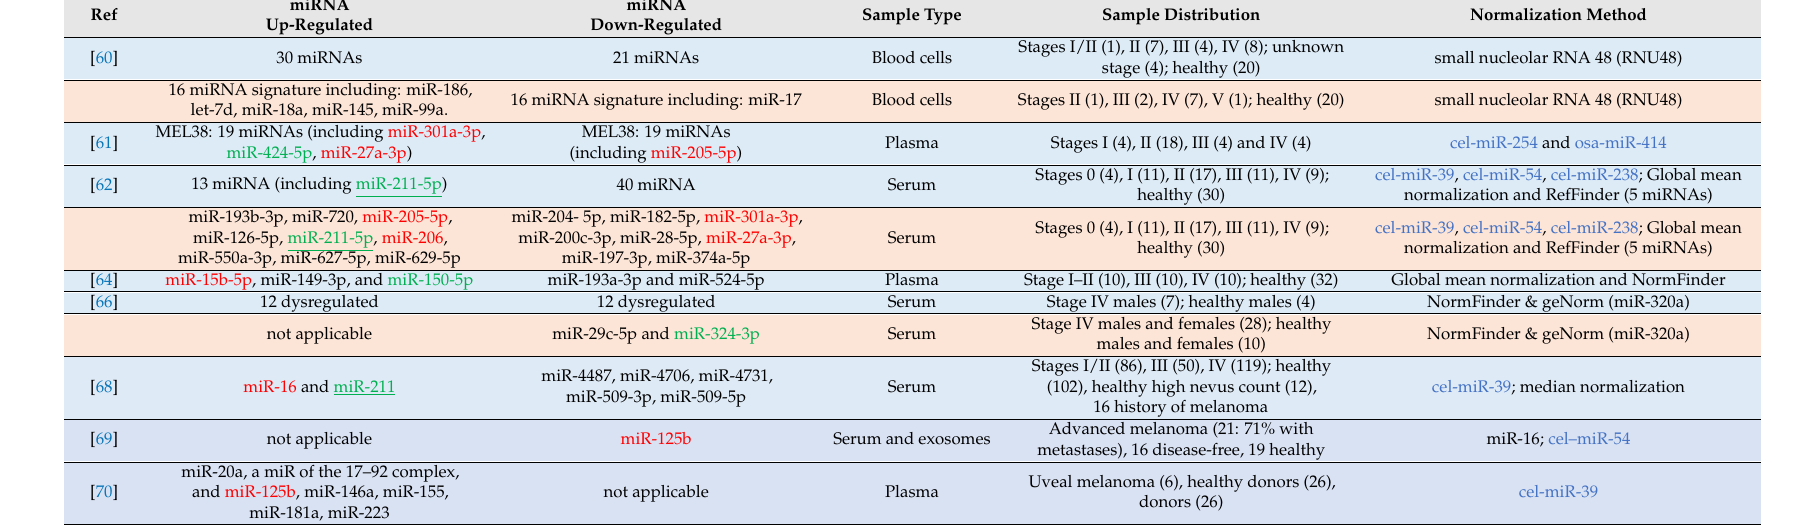
Table 1. Potential diagnostic circulating miRNA biomarkers for melanoma. This table summarizes the miRNAs found to be differentially expressed in the circulation of melanoma patients relative to healthy controls (Stage 0), highlighting the technical variables that may lead to the lack of consistency between studies. Pastel blue rows refer to discovery/training patient cohorts. Pastel orange rows refer to independent validation patient cohorts. MicroRNAs showing the same direction of change between multiple studies and/or have been verified using both a discovery and validation cohort are shown in green and those that additionally have used an acceptable normalization method and have been verified using an independent validation cohort are shown in green and are underlined. MicroRNAs showing a different direction of change between studies are shown in red. Exogenous spike-in controls are shown in blue. Further details are given in Table